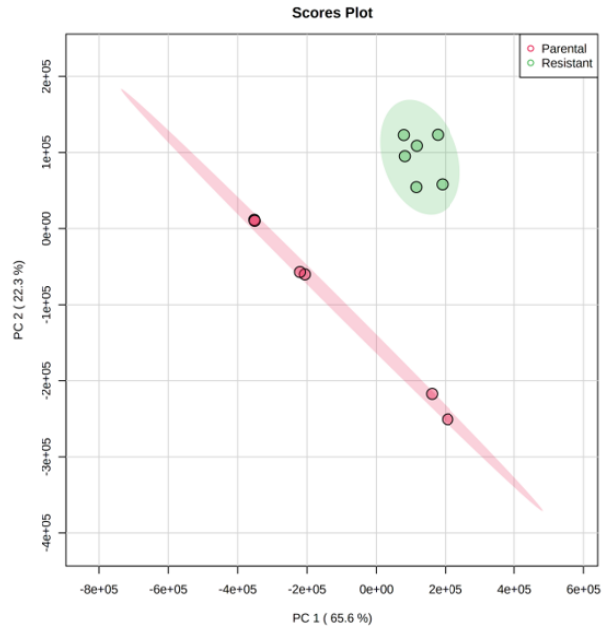
Figure 2. PCA of metabolic profile of parental and resistant Hep3B cells.